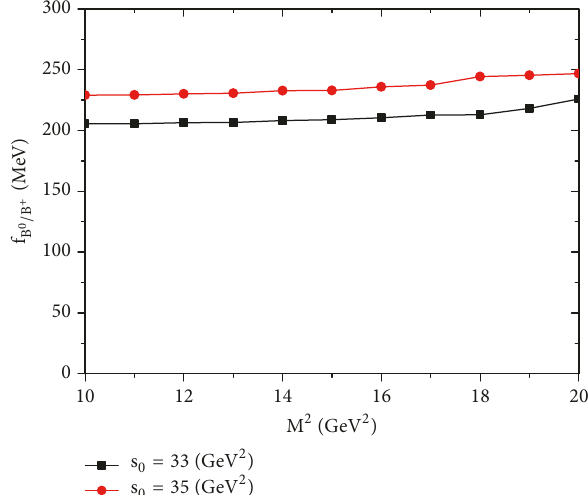
Figure 5: Borel parameter dependence of the 𝐷 0 /𝐷 + decay con- stants.